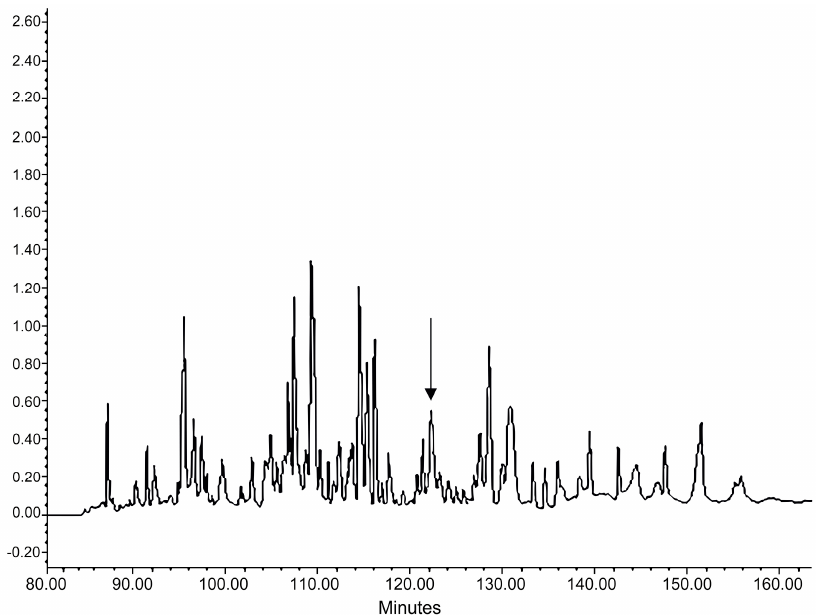
Figure 2. RP-HPLC chromatogram of Kassina senegalensis skin secretion at 214 nm. The fraction containing novel peptide, kassporin-KS1 (QUB-1641), is indicated by an arrow. The retention time was 122 min.